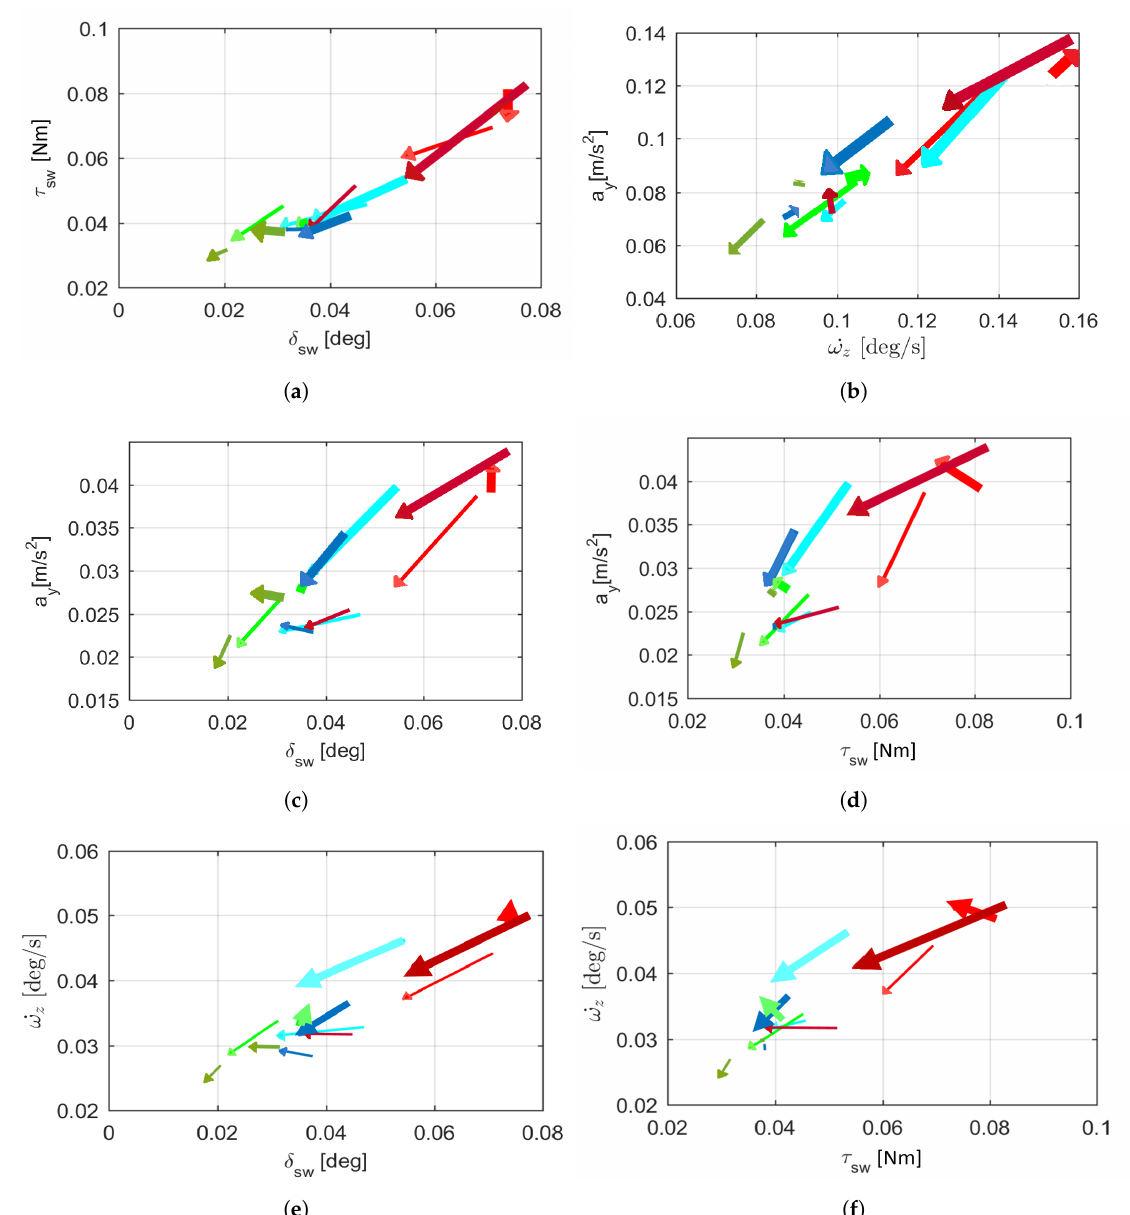
Figure 9. Standard deviation vector plots of each straight line L1 & L2 for the different configurations and speeds: ( a ) Steering torque τ sw vs steering angle δ sw . ( b ) Lateral acceleration a y vs yaw velocity ˙ ω z . ( c ) Lateral acceleration a y vs steering angle δ sw . ( d ) Lateral acceleration a y vs steering torque τ sw